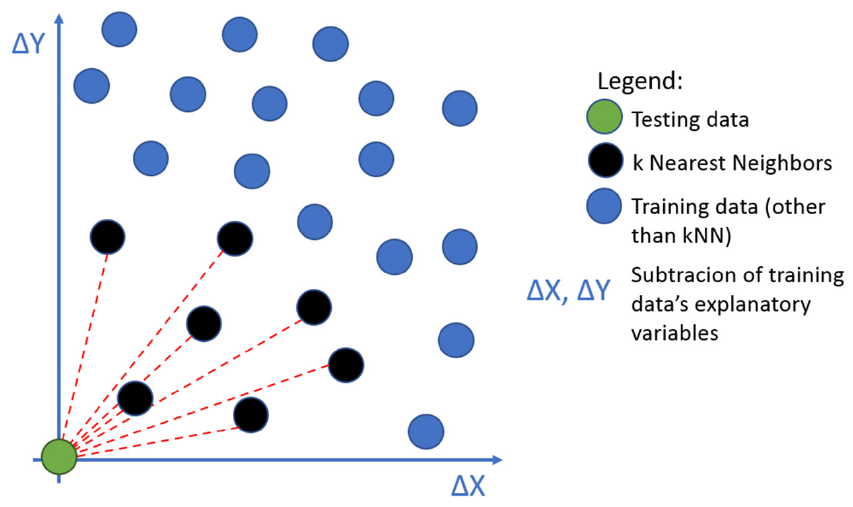
Figure 1. Example of choosing k nearest neighbors from the training data set for k = 7.